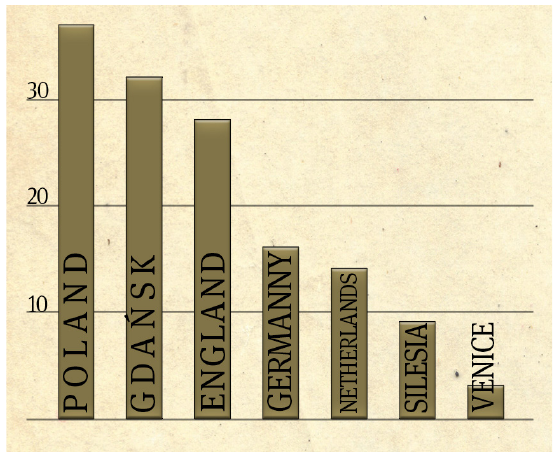
Figure 23. Chart of origin of lead seals from the discussed